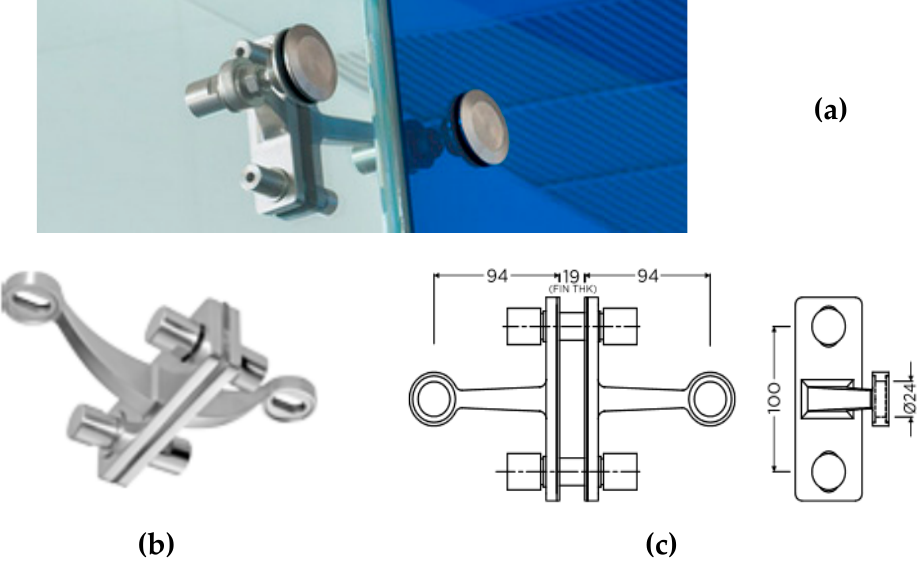
Figure 9. Example of two-way spider mechanical restraint for glass members: ( a ) global assembly with rotules; ( b ) axonometry detail; ( c ) nominal dimensions (top and side views, values in mm).